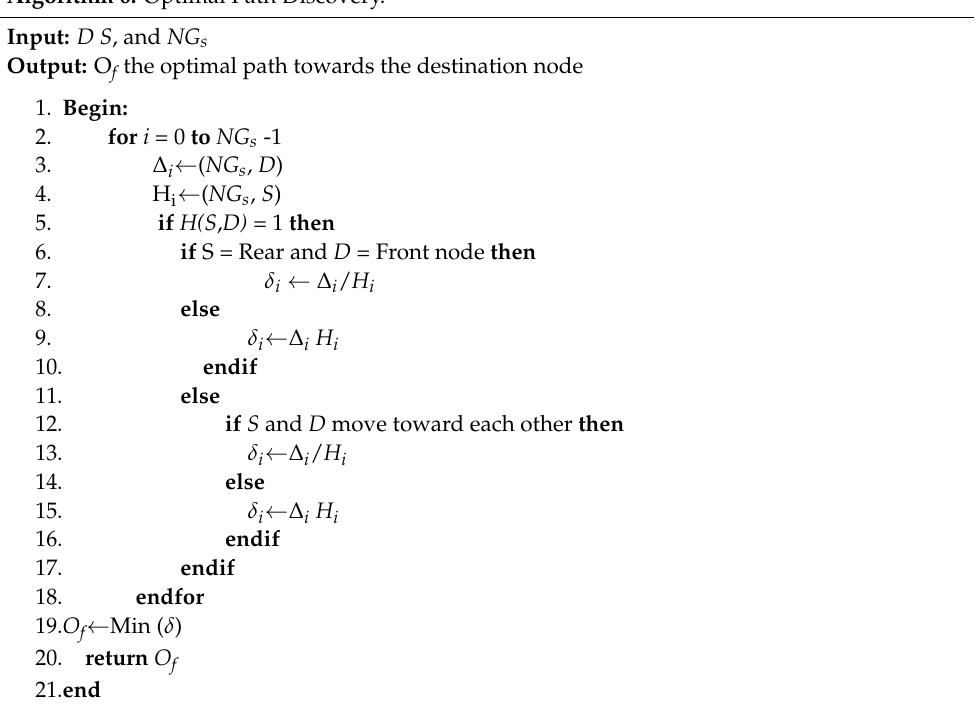
Algorithm 6: Optimal Path